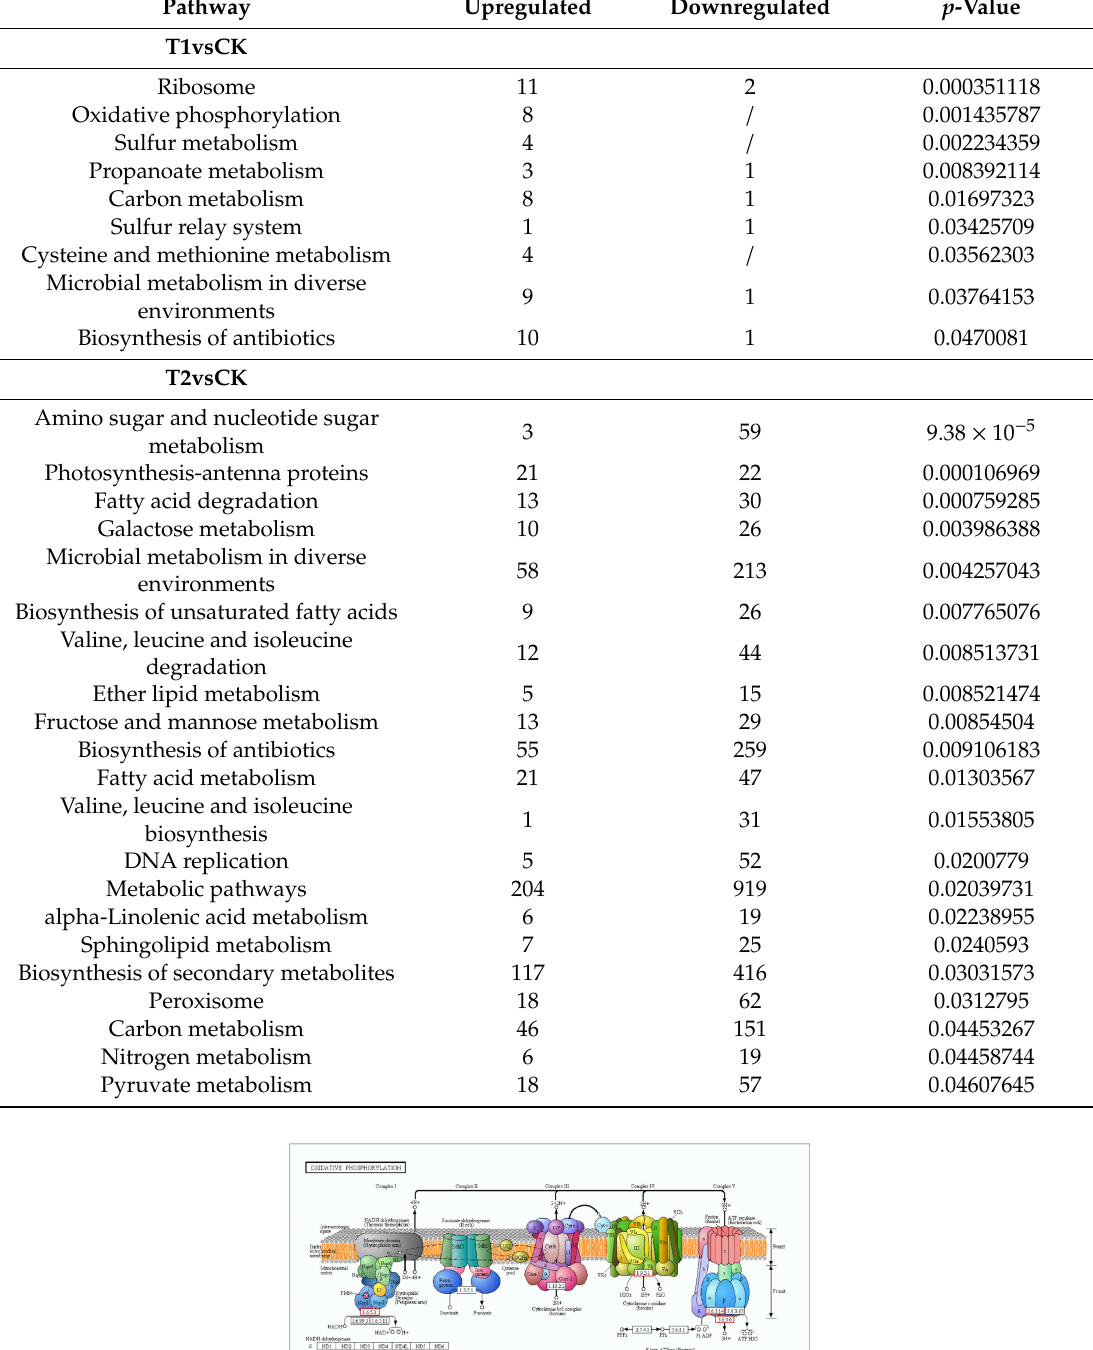
Table 3. The upregulated and downregulated genes within the Kyoto Encyclopedia of Genes and Genomes (KEGG).